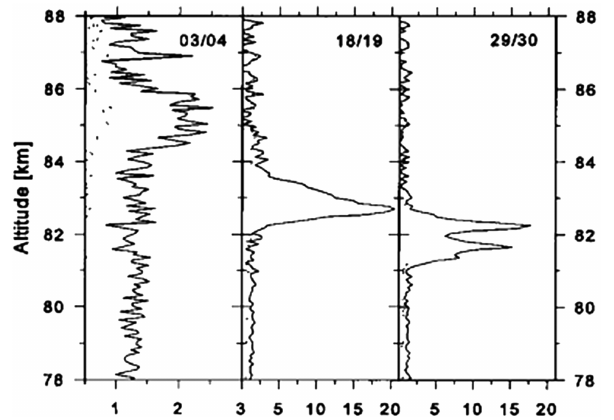
Figure 38. NLC over Juliusruh observed by HERMES-LIDAR, July 1995.